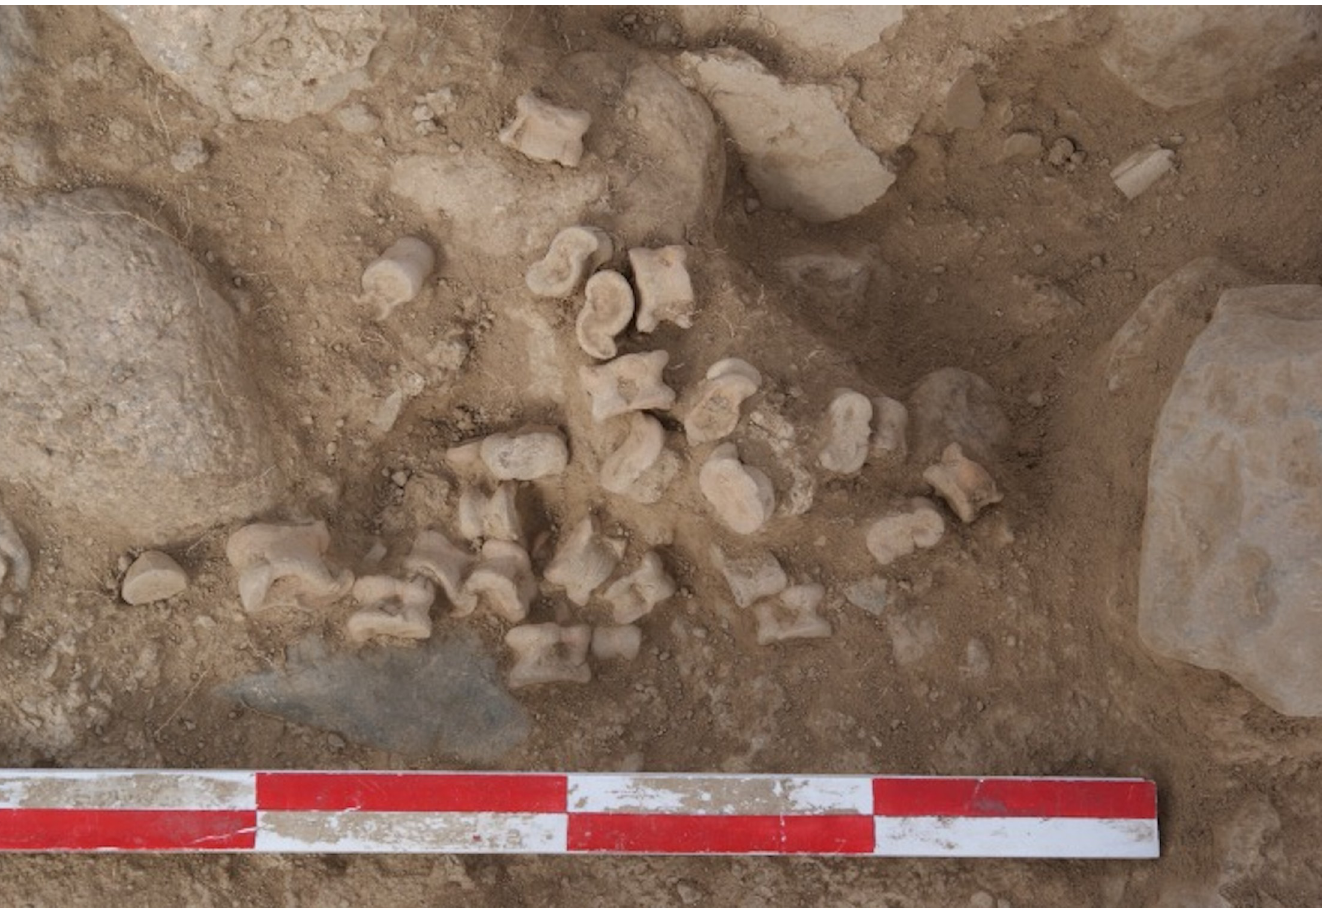
Fig 12. Worked caprine astragali from house F002 at